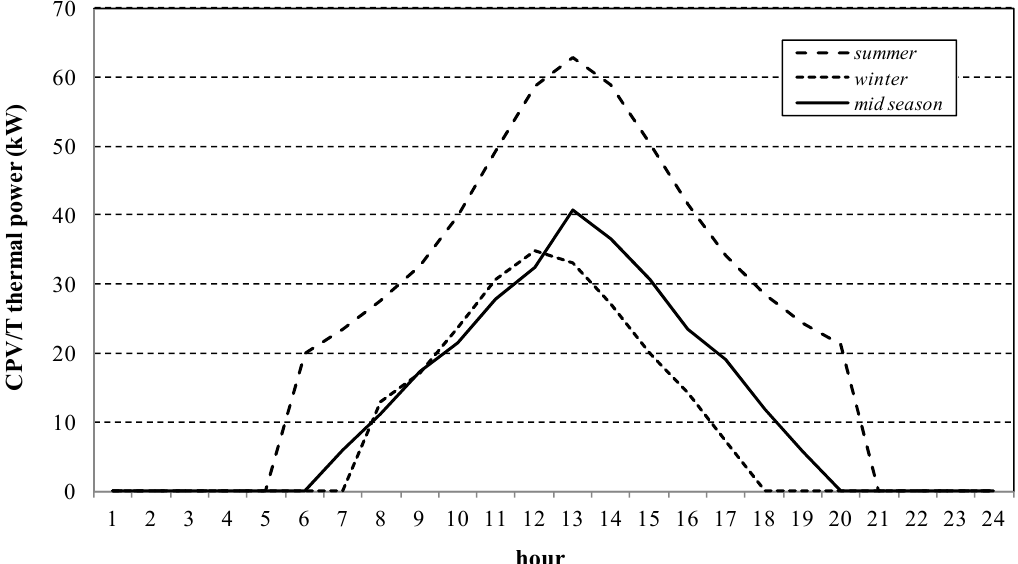
Figure 7. Thermal production of the CPV/T system in the summer, winter, and middle seasons.